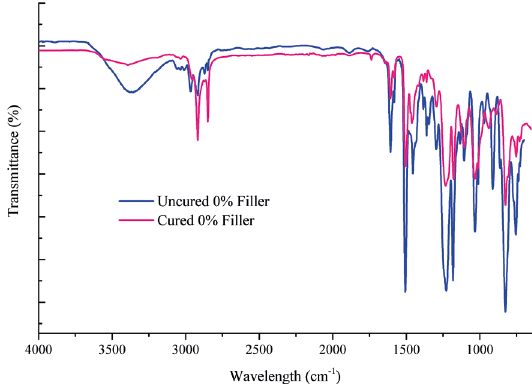
Figure 5. FTIR spectrum for the mixture with 0% filler mixture before and after curing